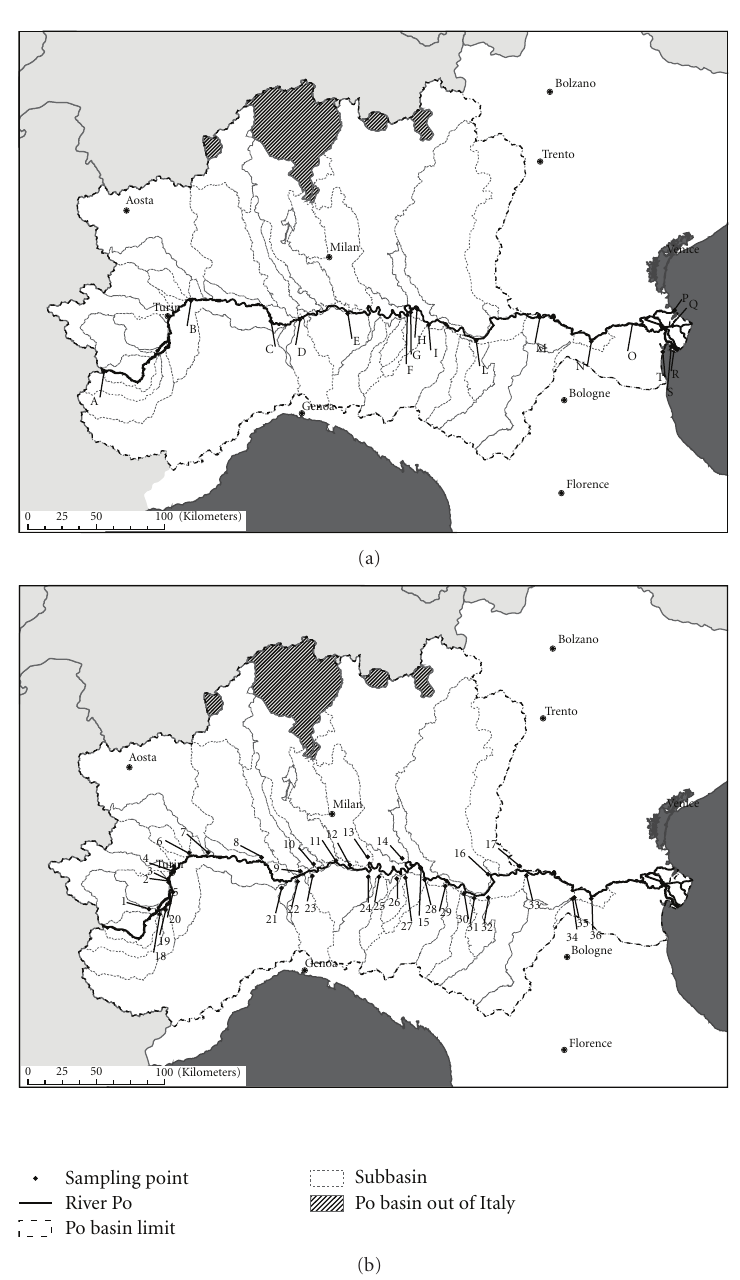
Figure 1: Sampling points along river Po (a) and its tributaries